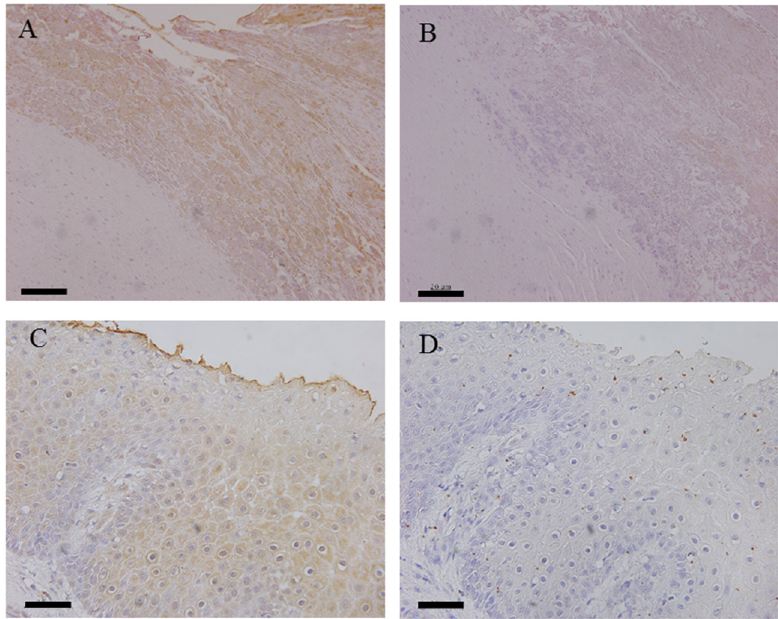
Figure 3. Detection of antigens of T. phagedenis and F. necrophorum by immunohistochemistry. ( A ), No. 2 (TN) using by rabbit polyclonal antibodies against T. phagedenis. ( B ), No. 2 (TN) using normal rabbit serum. ( C ), No. 9 (nhSU) using by rabbit polyclonal antibodies against F. necrophorum . ( D ), No. 9 (nhSU) using by normal rabbit serum. Bar = 20 µ m